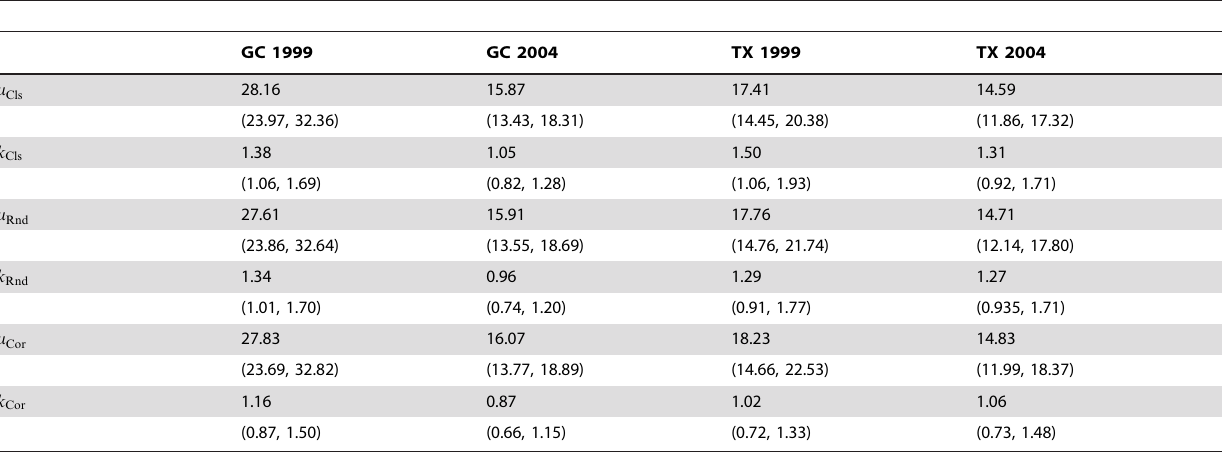
Table 3. The upper section contains grid-specific maximum likelihood estimates of the mean ( m ( k Cls ) obtained by directly fitting the classical NBD to the larval burden data via maximum likelihood.